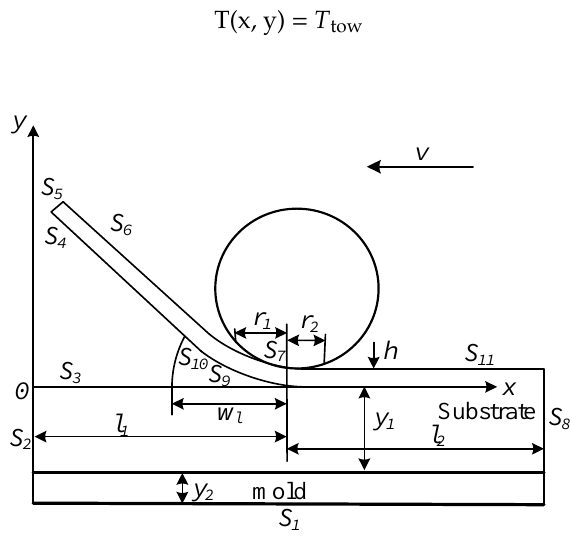
Figure 3. Geometric model of thermoplastic fiber automatic placement.